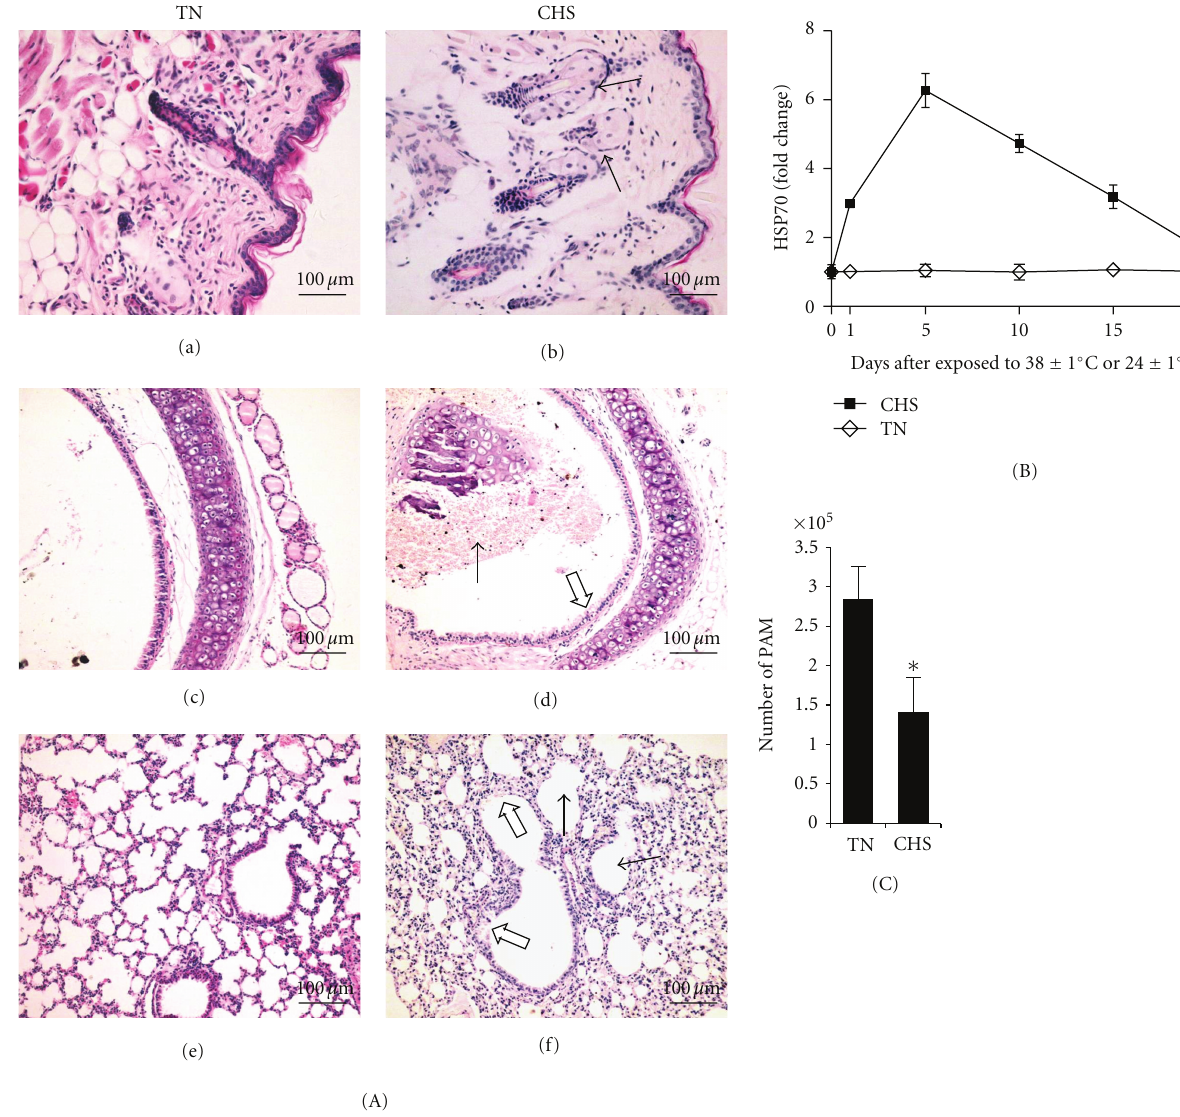
Figure 1: Analysis of the local immunity in the respiratory tract of mice. (A) Representative sections from each group were stained by H&E after exposed to 38 ± 1 ◦ C or 24 ± 1 ◦ C over 21 days (400 × ). (a) Normal nasal sections from TN mice. (b) Nasal lesions from CHS mice. Solid arrows indicate sebaceous gland hyperplasia. (c) Normal tracheal sections from TN mice. (d) Tracheal lesions from CHS mice. Solid arrows indicate erythrocytes infiltrated in the tube cavity of the trachea and unshaded arrows indicate the dropout of trachea epithelium cells. (e) Normal lung section from TN mice. (f) Lung lesion from CHS mice. Solid arrows indicate alveolar expansion and unshaded arrows indicate a reduction and necrosis of mucous epithelial cells. (B) The mRNA levels of HSP70 in the lungs were determined by qPCR at various time-points. (C) PAM counting from BAL was performed after exposure to 38 ± 1 ◦ C or 24 ± 1 ◦ C for 21 days. These results are the mean ± SD values obtained from three distinct animals and are representative of three independent experiments. ∗ indicates P < . 05 when compared with the TN group. TN: thermally neutral; CHS: chronic heat